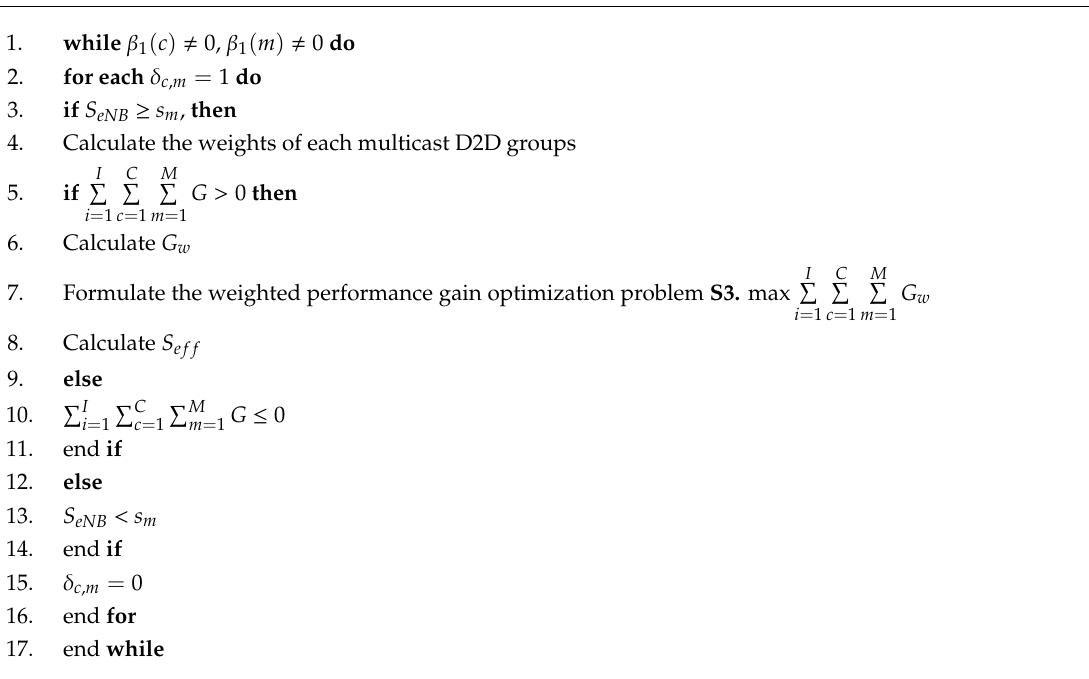
Algorithm 3 : Pseudo Code for the Auction-based Matching